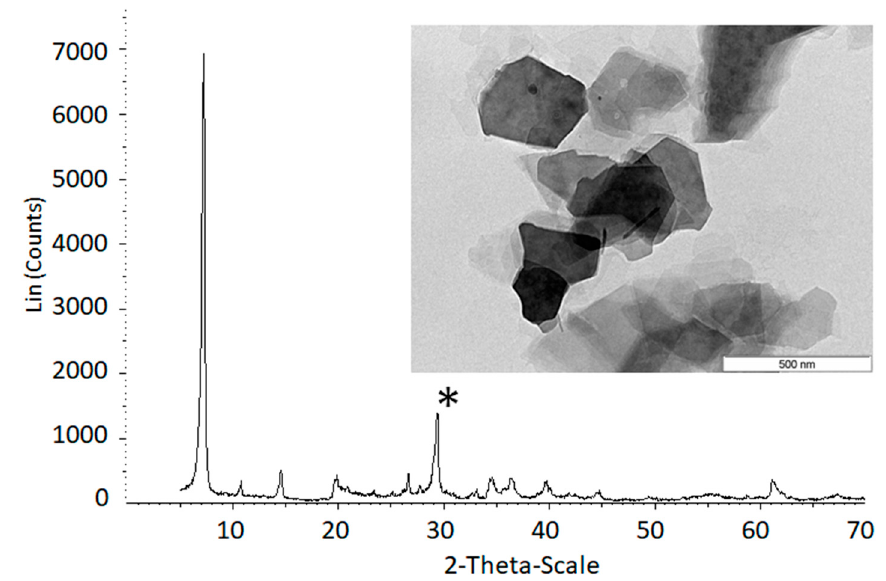
Figure 2. TEM micrograph and XRD of the purified fluorohectorite (Li-FH). * antophyllite.